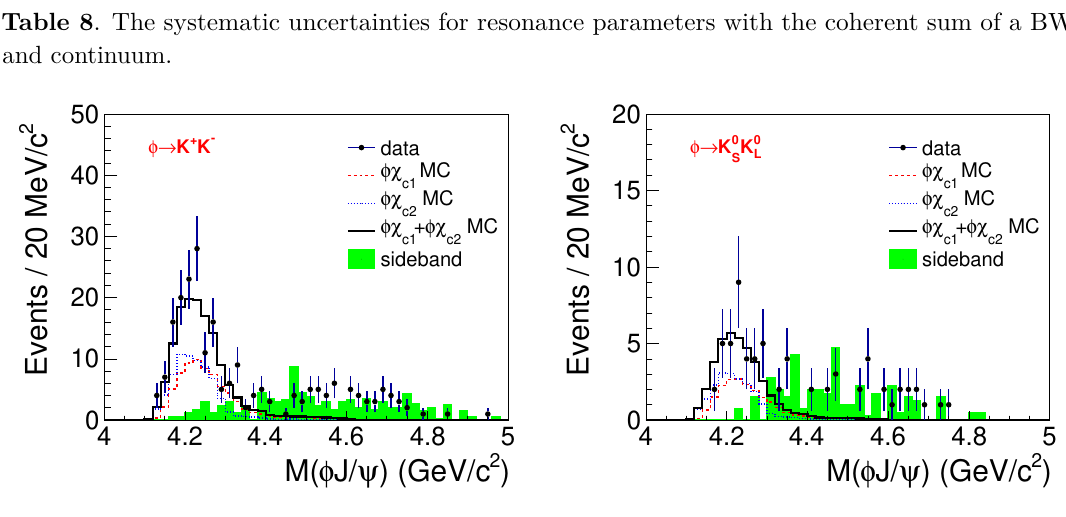
Figure 7 . The invariant mass distribution of M ( φJ/ψ ) in the φ → K + K − and φ → K 0 Dots with error bars are the full data, the red dashed and blue dotted histograms are from φχ c 1 and φχ c 2 MC, which have been normalized to the data, the black solid histograms are the sum of φχ c 1 and φχ c 2 , and the green filled histograms are the φ − J/ψ 2-dimensional